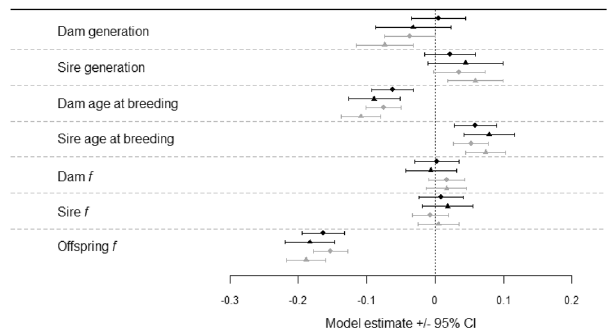
Fig. 1 Model estimates for offspring survival analyses (±95% CI). Black circle is the average model estimate of the pooled results ( N = 5 models) from random selection of one offspring per litter/clutch ( N = 21,282 individuals), black triangle is the average model estimate of the pooled results ( N = 5) from G 2 + subset of this model ( N = 16,514 – 16,516 individuals), grey circle is the model estimate of the extended dataset model ( N = 37,484) after model averaging, grey triangle is the model estimate of the G 2 + subset of this model ( N = 27,734) after model averaging. Positive estimates represent a positive relationship with offspring survival to reproductive